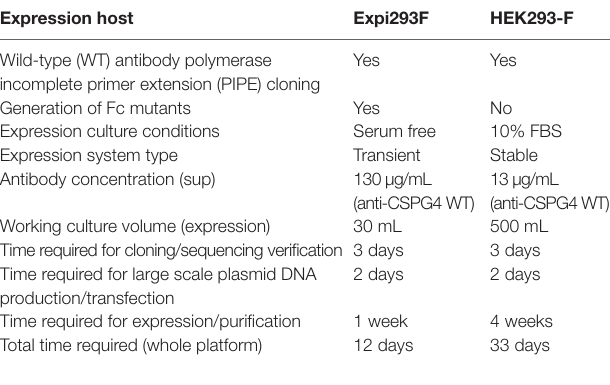
Table 3 | Characteristics of the Expi293F vs. the HEK293-F cloning/expression platforms. expression host